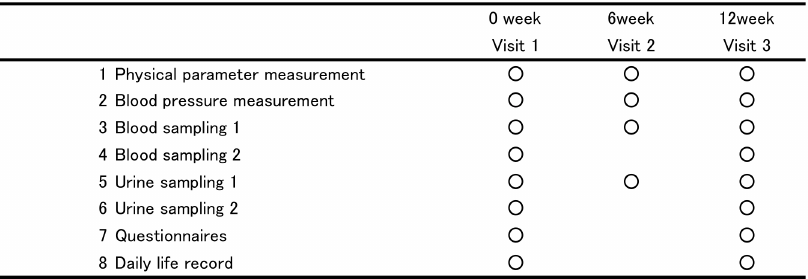
Figure 1. The schematic representation of study protocol. 1. the measure of height, body weight, waist circumference. 2. the measure of systolic blood pressure, diastolic blood pressure, heart rate. 3. total cholesterol, triglyceride, low-density lipoprotein cholesterol, high-density lipoprotein cholesterol, fasting plasma glucose, glycated hemoglobin (HbA1c), glycoalbumin (GA), immunoreactive insulin (IRI), aspartate transaminase (AST), alanine transaminase (ALT) and γ -glutamyltransferase ( γ -GT), blood cell count, hemoglobin, hematocrit, platelet. 4. soluble lectin-like oxidized LDL receptor-1 (sLOX-1), LOX-1 ligand including ApoB(LAB), LOX index, pentosidine, adiponectin, serum iron and ferritin. 5. Urinalysis. 6. urinary 8-hydroxydeoxyguanosine (8-OH-dG) level. 7. the Food Frequency Questionnaire. 8. records of their individual adherence to eating test ice cream and their physical conditions.